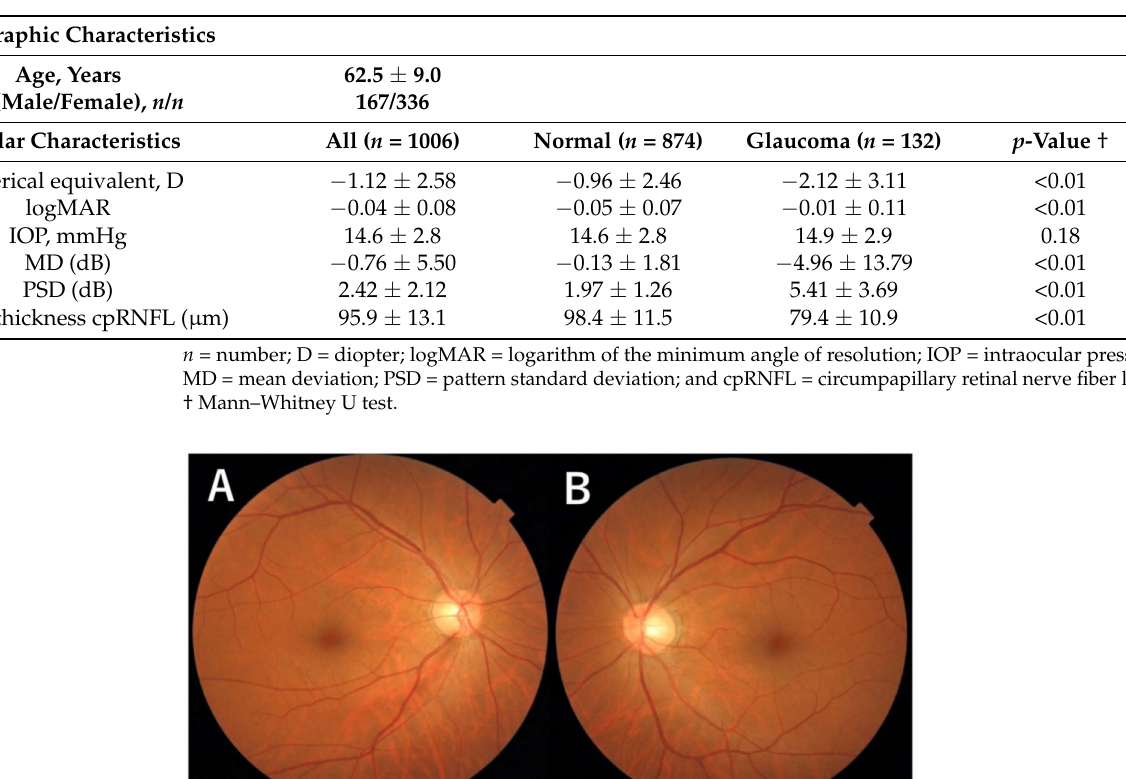
Table 1. Characteristics of study participants.